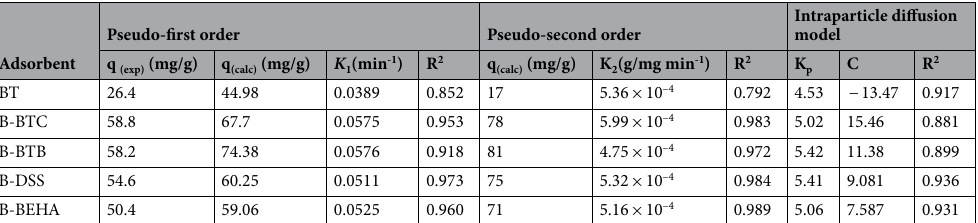
Table 1. Kinetics results of Pseudo first order, Pseudo second order and Intraparticle diffusion model for the adsorption of DBT onto BT, B-BTC, B-DSS, B-BTB and B-BEHA.